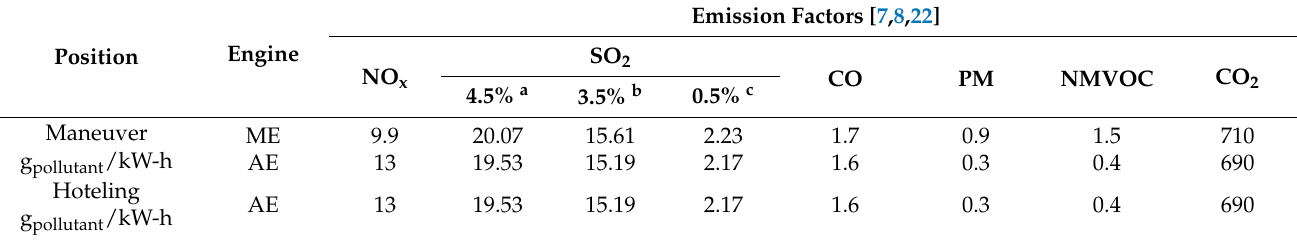
Table 3. Emission factors (g pollutant /kW-h) for estimating atmospheric emissions in Mexico. Data available for Emission Factors were adapted from